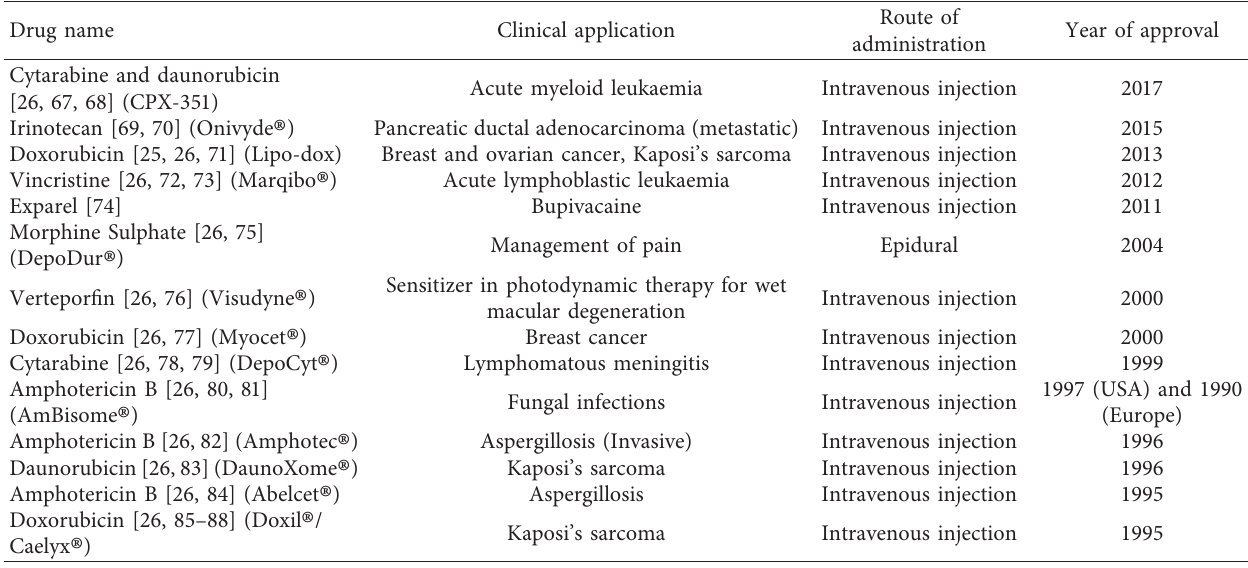
Table 2: An illustration of the approved liposomal products currently on the market with their year of approval, intended clinical ap- plication, and preferred route of administration.